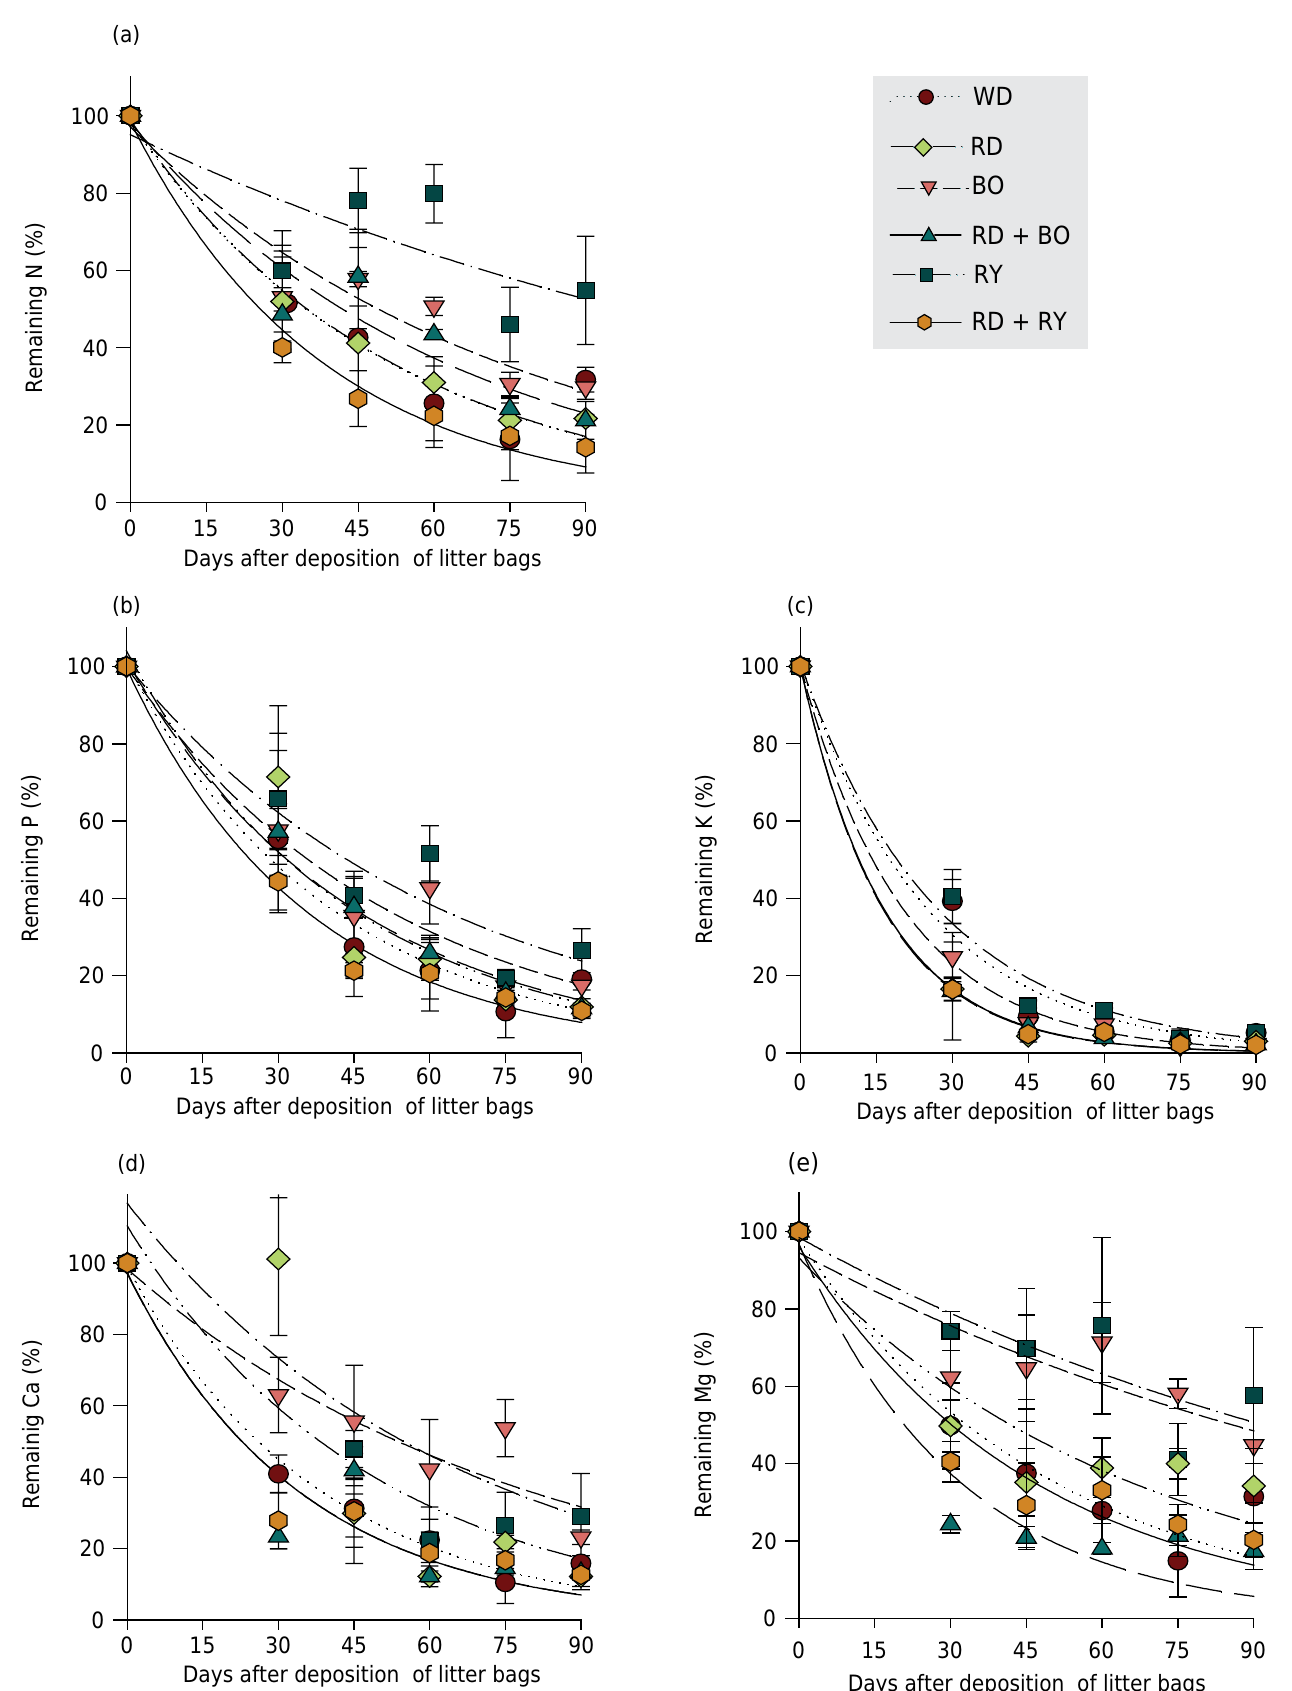
Figure 3. Remaining percentage of nitrogen (N) (a), phosphorus (P) (b), potassium (K) (c), calcium (Ca) (d), and magnesium (Mg) (e) in the residues of weeds (WD), black oat (BO), rye (RY), oilseed radish (RD), oilseed radish + black oat (RD + BO), and oilseed radish + rye (RD + RY) deposited on the onion crop row for a period of 90 days. Vertical bars represent standard error of the